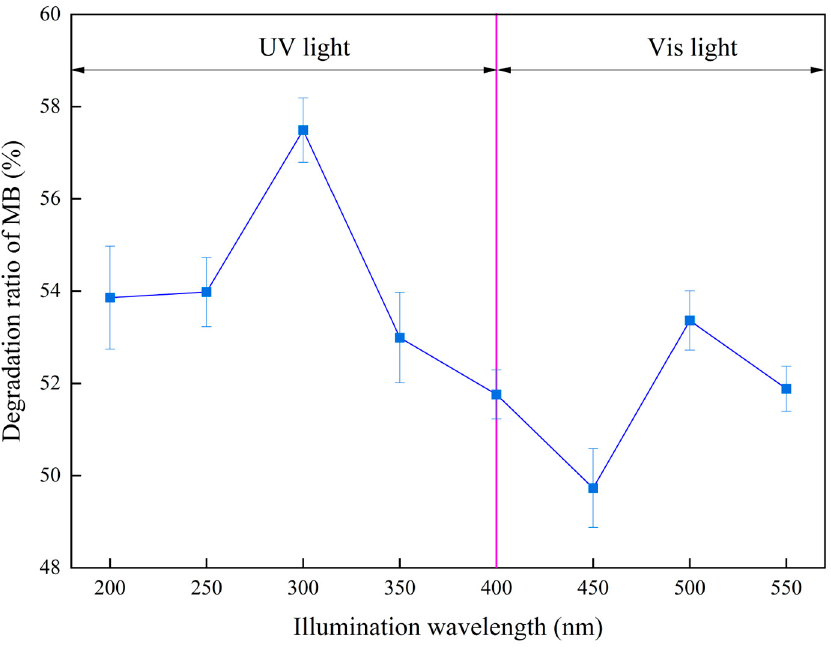
Figure 7. The e ff ect of illumination wavelength on the photocatalysis of MM-CaTiO 3 . Figure 7. The effect of illumination wavelength on the photocatalysis of MM-CaTiO 3 .